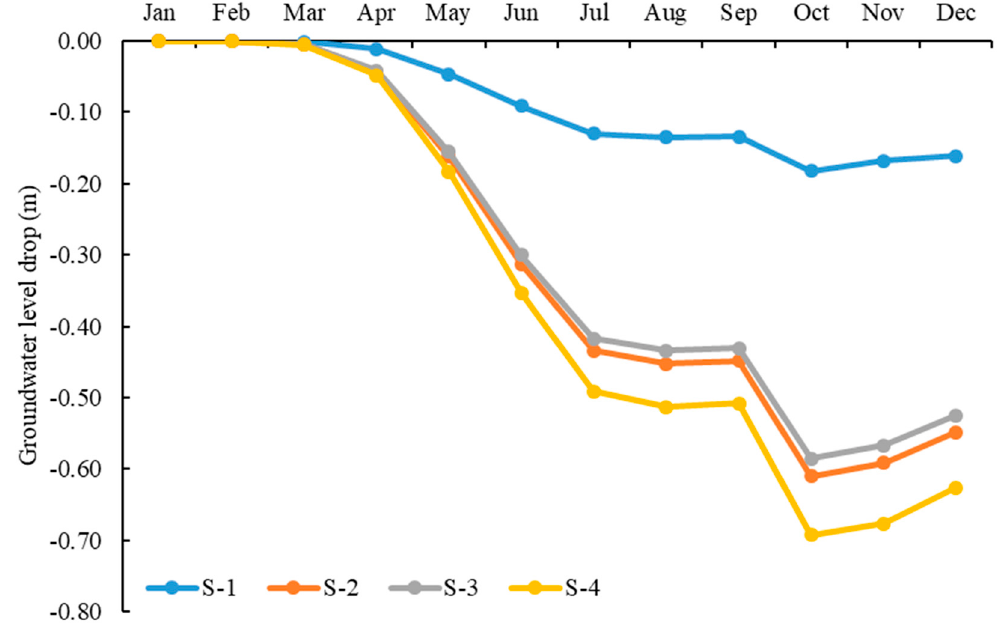
Figure 6. Average drops of groundwater level in four typical scaled water-saving irrigation scenarios.